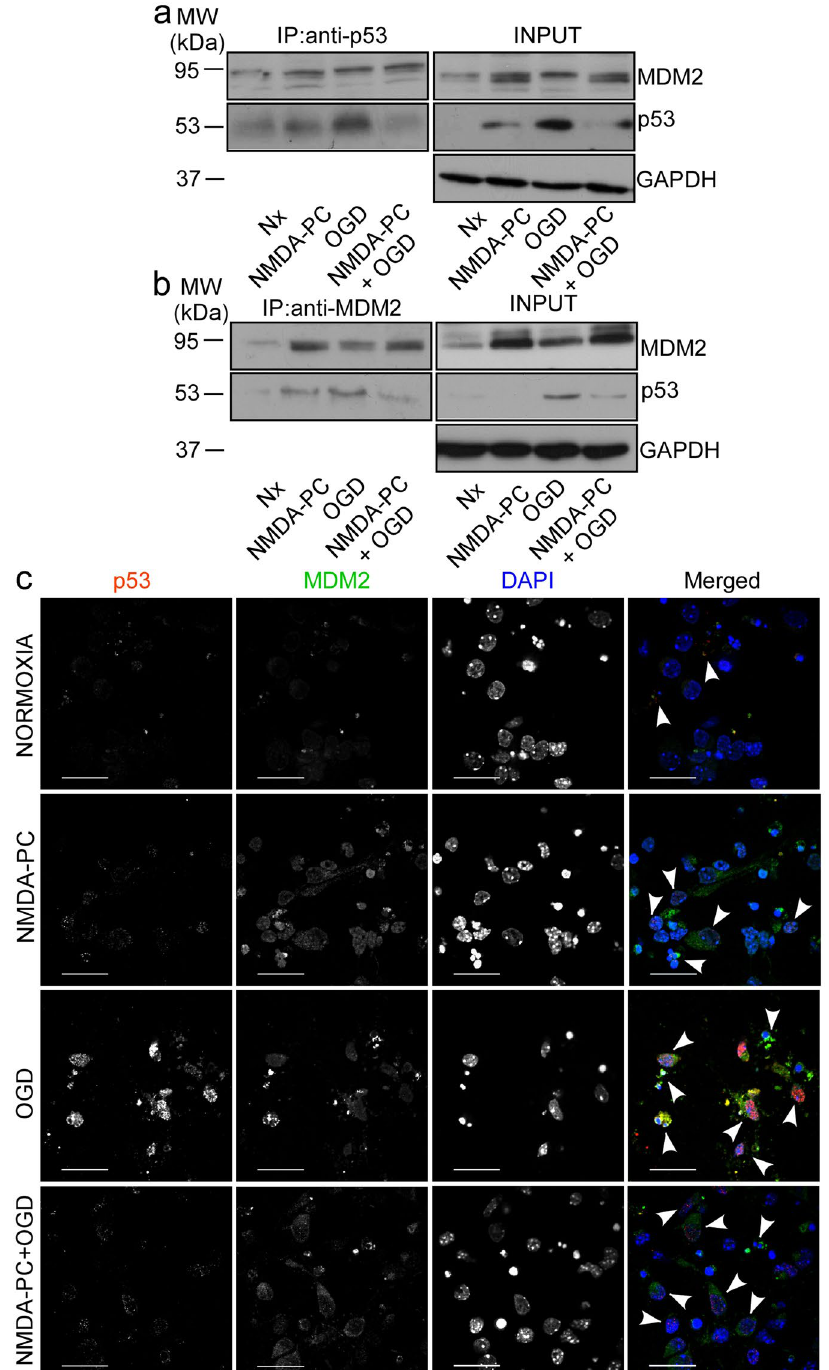
Figure 5. NMDA-PC promotes MDM2-p53 interaction, which prevents ischemia-induced p53 stabilization. Mouse cortical neurons (9–10 DIV) were exposed to a validated in vitro model of NMDA-PC (Table 1). Neuronal extracts were obtained and immunoprecipitated with anti-p53 ( a ) and anti-MDM2 ( b ) antibodies. Of the whole cellular extracts used for immunoprecipitation, 10% were loaded on SDS-PAGE as an input control. A representative western blot image is shown of three. ( a , b ) Co-immunoprecipitation assays revealed that p53 co-precipitated with MDM2. ( a , b ) NMDA-PC prior OGD, promotes MDM2-p53 interaction. ( c ) Fluorescence microphotographs revealed that NMDA-PC increases MDM2 protein levels, which appears to be the main effect for NMDA-PC promoting MDM2-p53 interaction at 4 hours after OGD. Although OGD promoted MDM2-p53 interaction, this effect was not enough to prevent OGD-induced p53 stabilization.White arrowheads show MDM2-p53 interaction. Scale bar = 20 μ m. Relative percentages of neurons with p53-staining/MDM2-staining are presented in Supplementary Fig. S1. Relative protein abundances quantification Fig. 5a and Fig. 5b are presented in Supplementary Fig. S2 and that “full-length blots/gels are presented in Supplementary Fig.